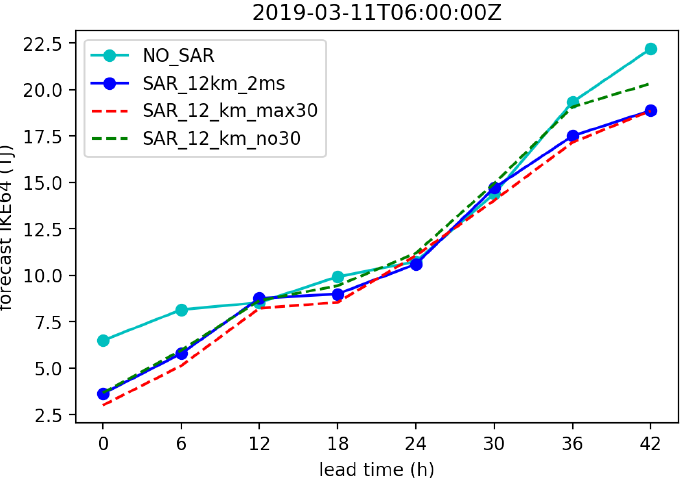
Figure 24. Evolution of IKE in the forecast of 11 March 2019 06:00Z for NO_SAR, SAR_12km_2ms, SAR_12km_max30, SAR_12km_no30.